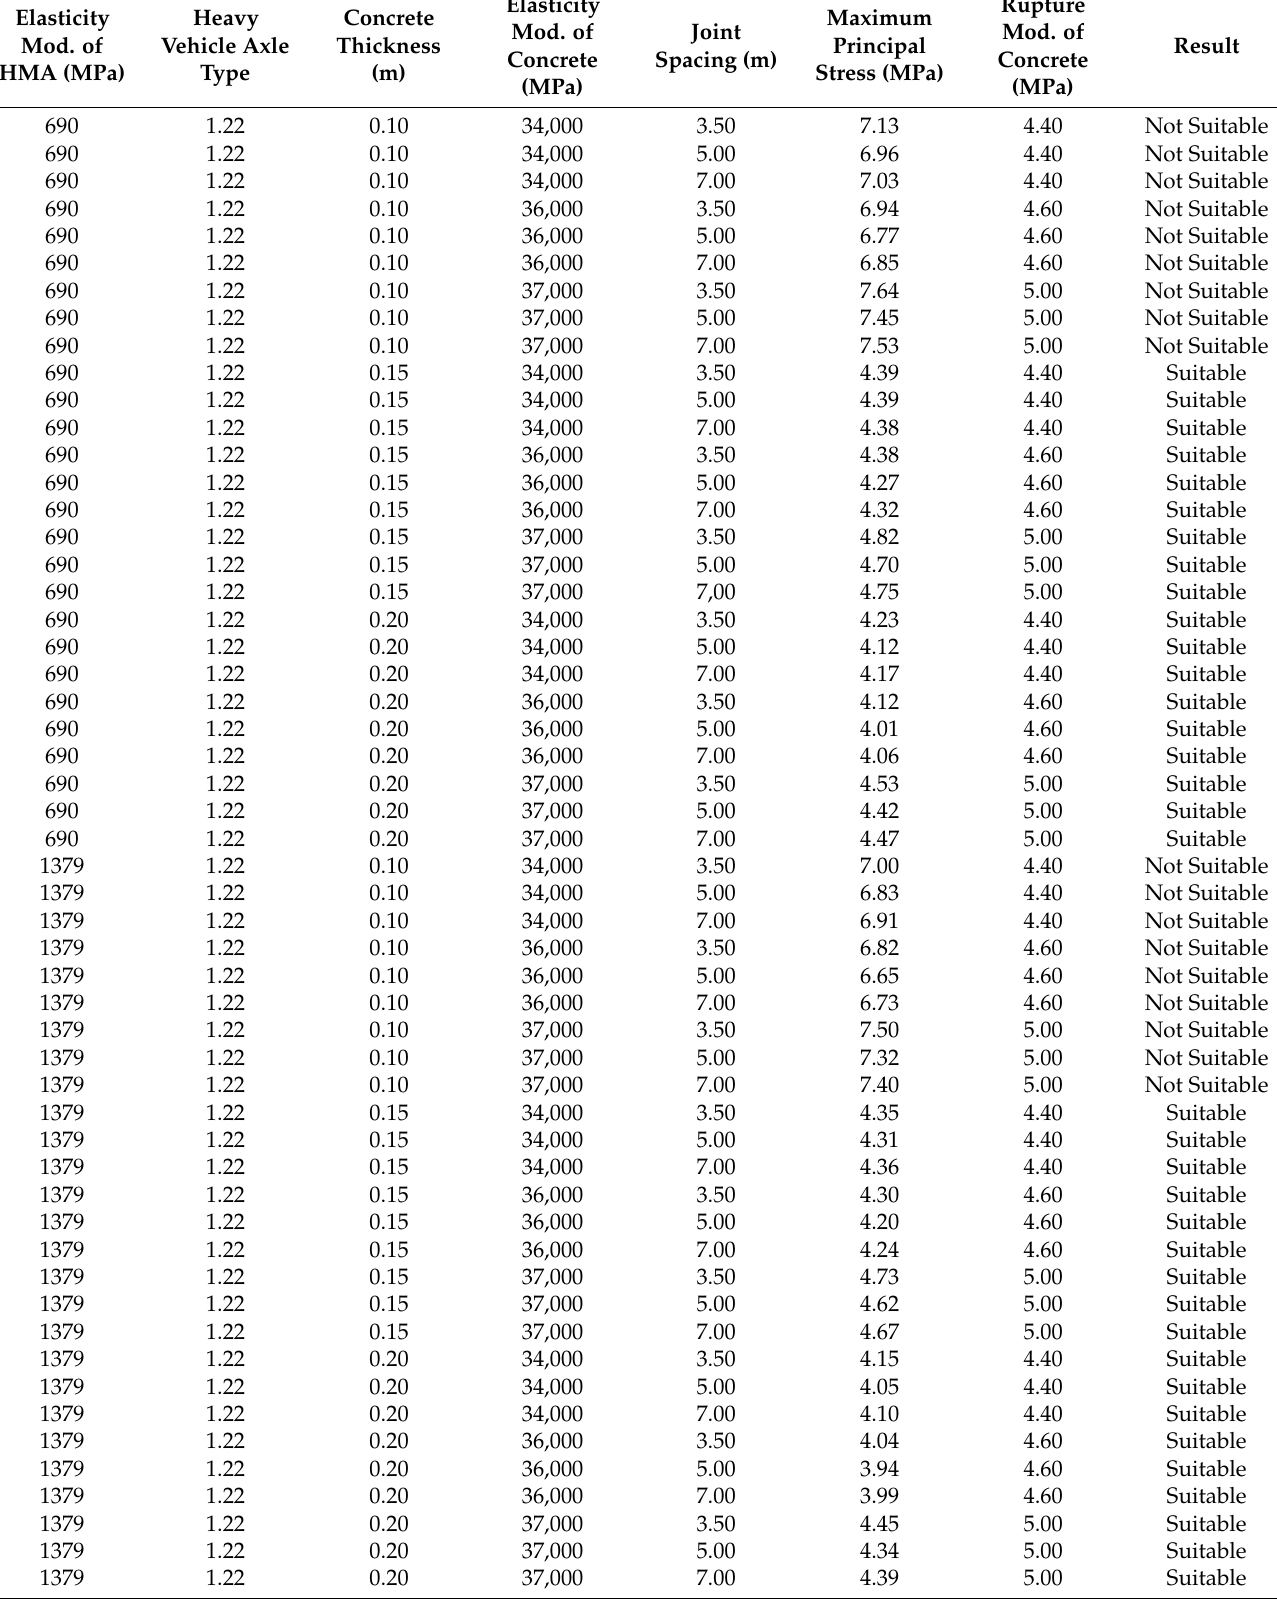
Table 12. Maximum principal stress tables for three-axle type (1.22)